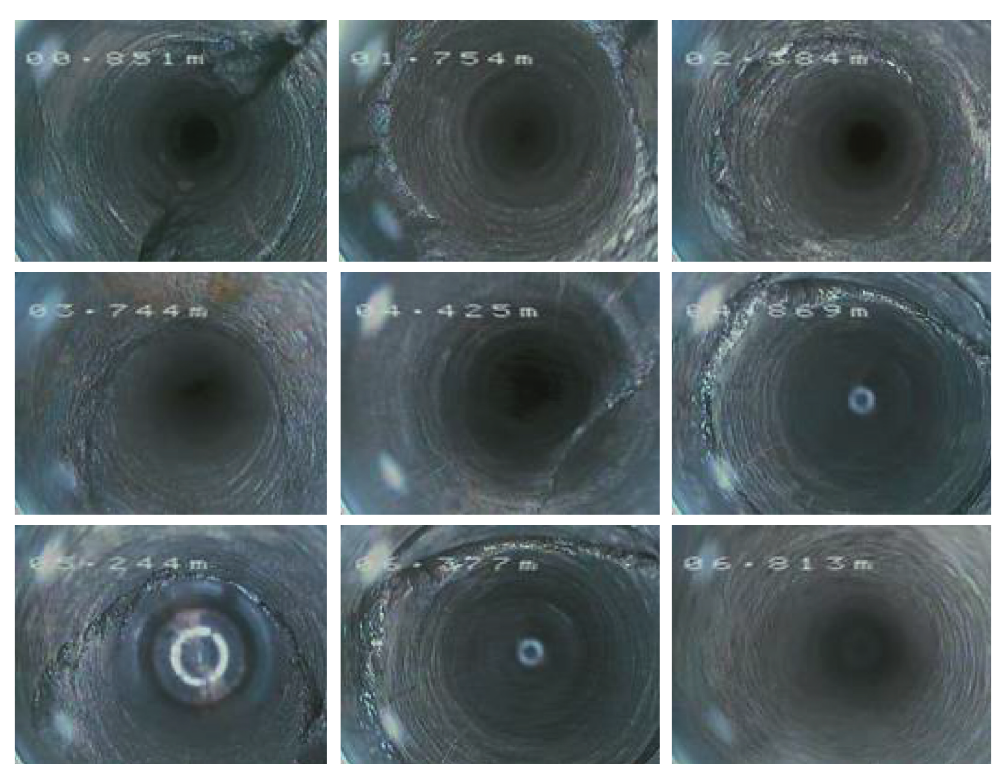
Figure 15: The result of borehole TV